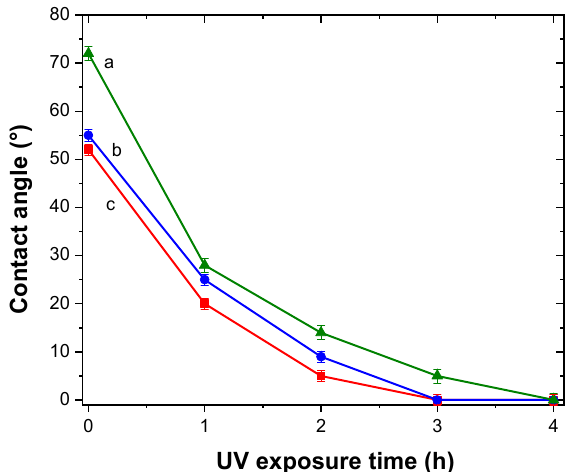
Figure 8. Variation of water contact angles under UV illumination with time for TiO 2 / AlZr bilayer samples deposited at ( a ) 500 °C, ( b ) 540 °C, and ( c ) 550 °C.